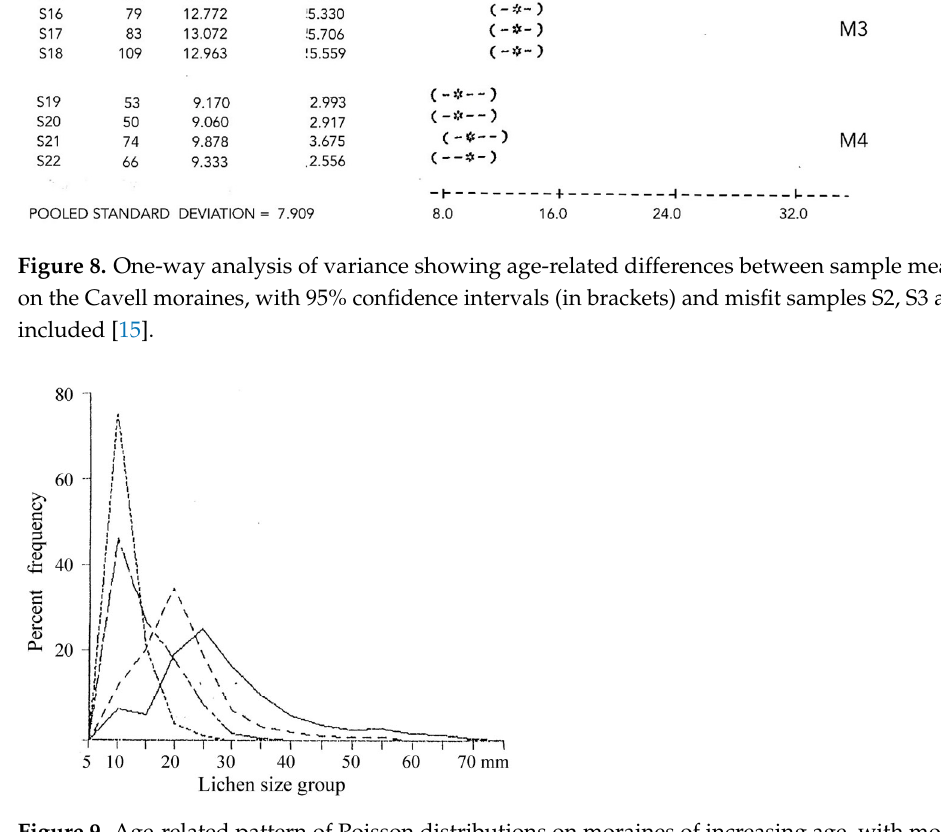
Figure 9. Age ‐ related pattern of Poisson distributions on moraines of increasing age, with modes of decreasing frequency and increasing size ‐ class as age increases [96].